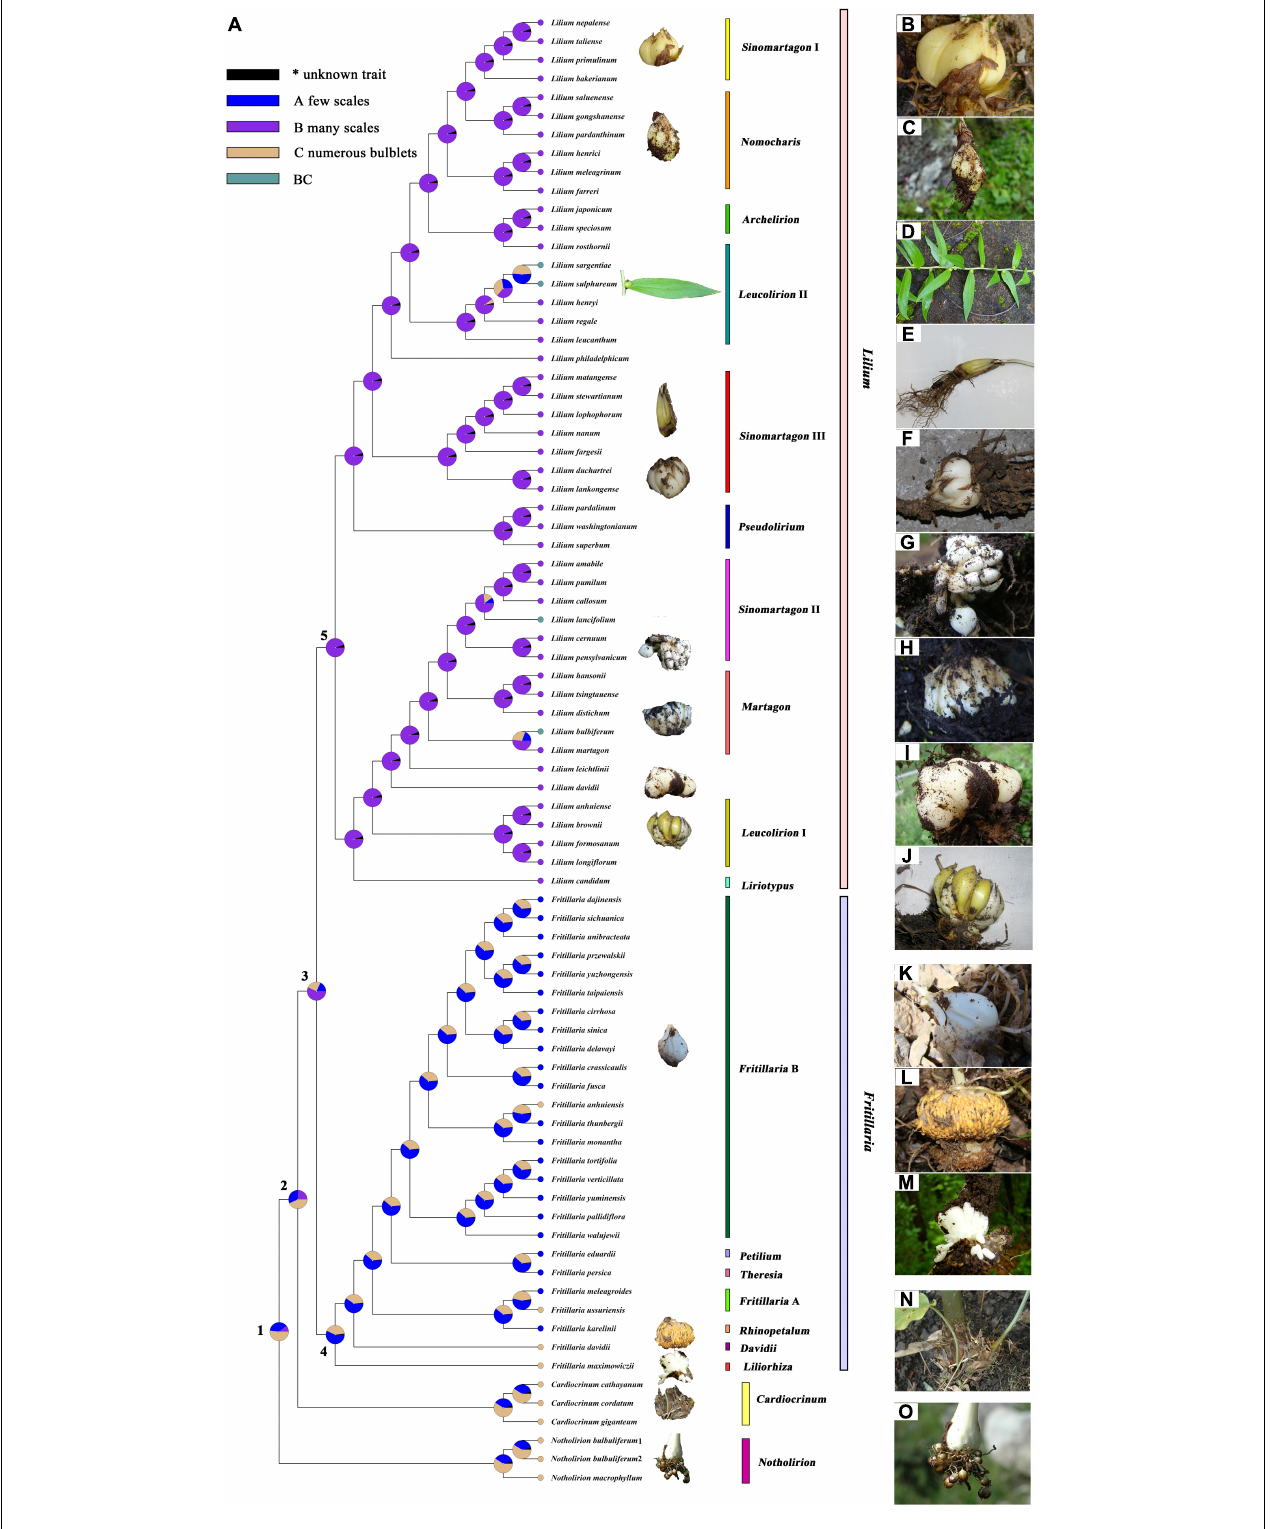
FIGURE 4 | Reconstruction of the ancestral trait of Liliaea bulbs. (A) Reconstruction of the ancestral trait; (B–O) Bulb types of selected Lilieae species: (B) L. taliense , (C) L. pardanthinum , (D) L. sulphureum , (E) L. lophophorum , (F) L. duchartrei , (G) L. pensylvanicum , (H) L. distichum , (I) L. davidii , (J) L. brownii , (K) F. delavayi , (L) F. davidii , (M) F. maximowiczii , (N) C. giganteum , and (O) N. bulbuliferum .